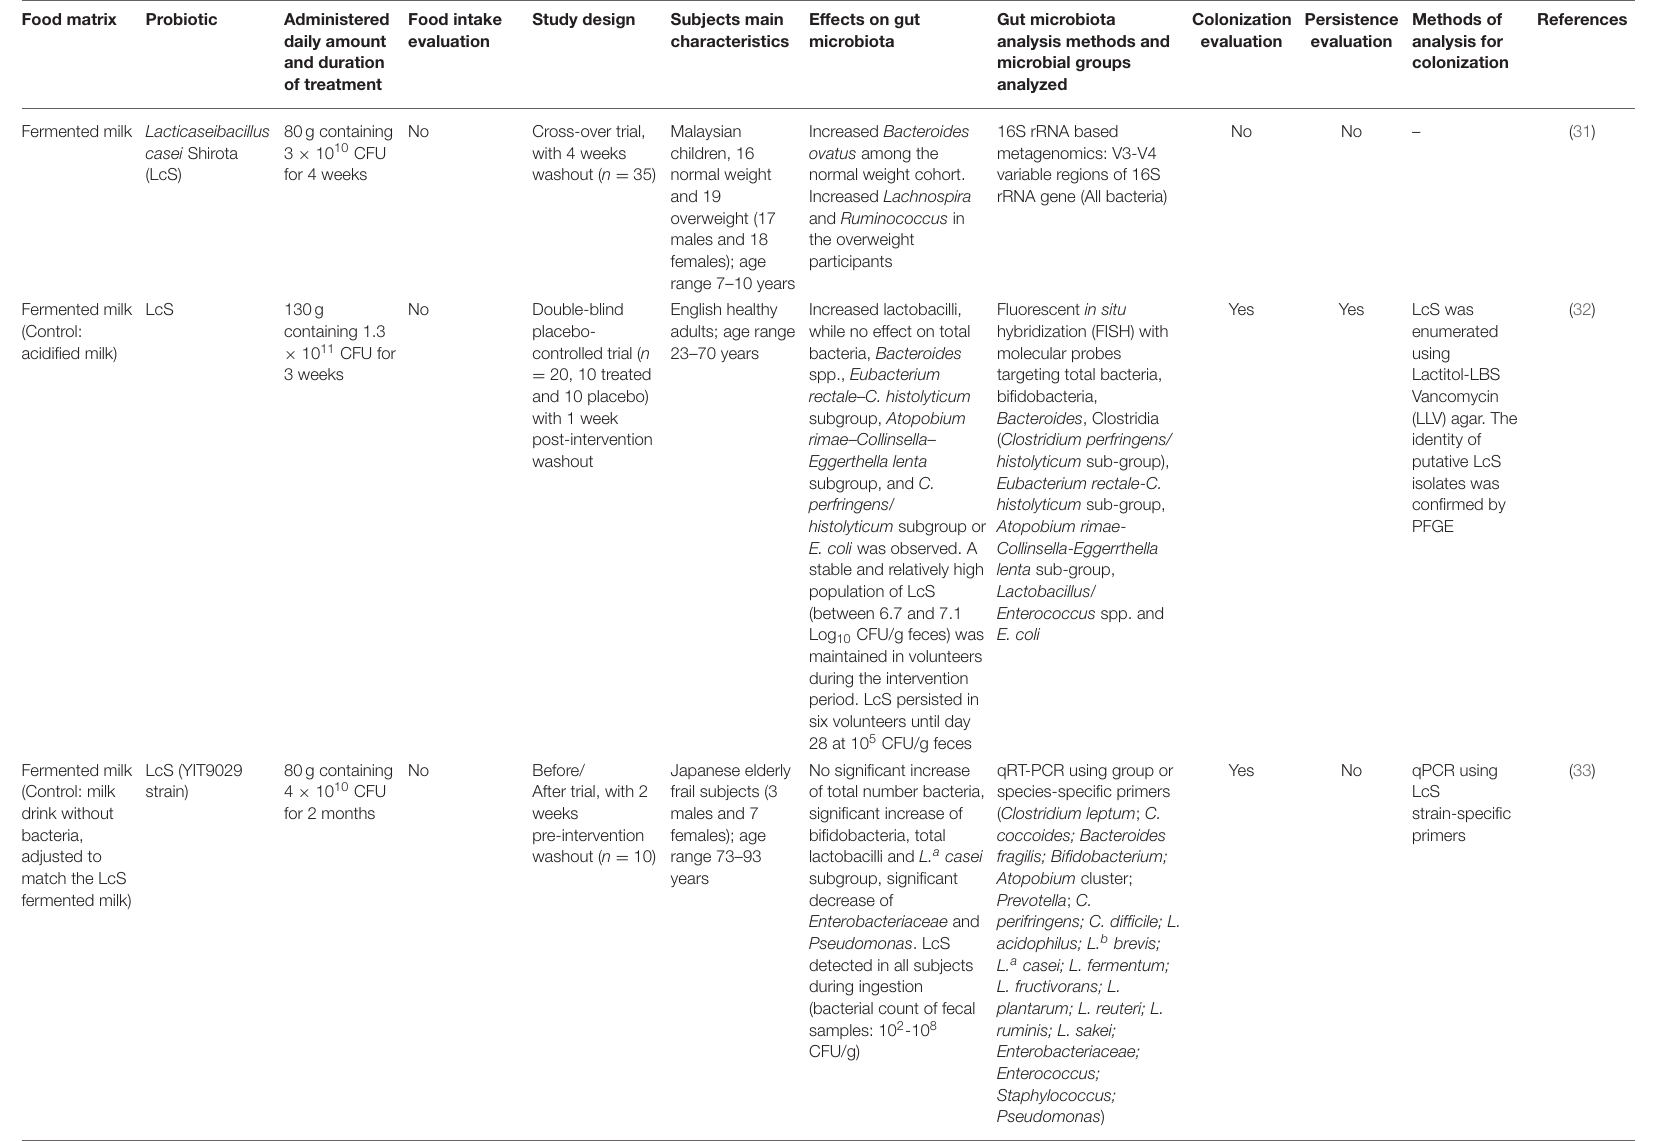
TABLE 3 | Human intervention studies using fermented foods containing the probiotic Lacticaseibacillus casei Shirota